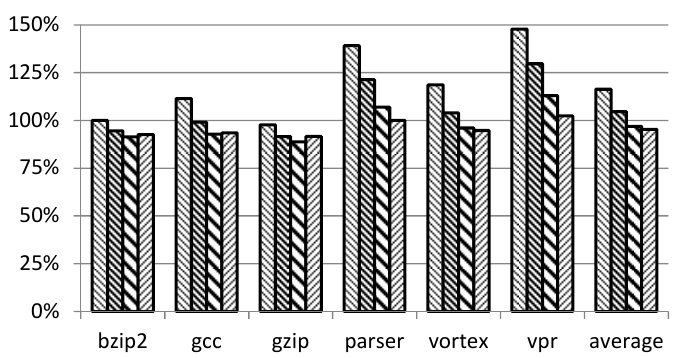
Figure 11. Relative power consumption (30%-scenario,